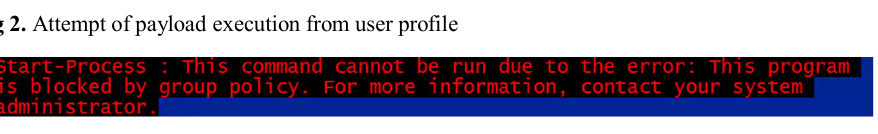
Fig 3. AppLocker blocks payload execution